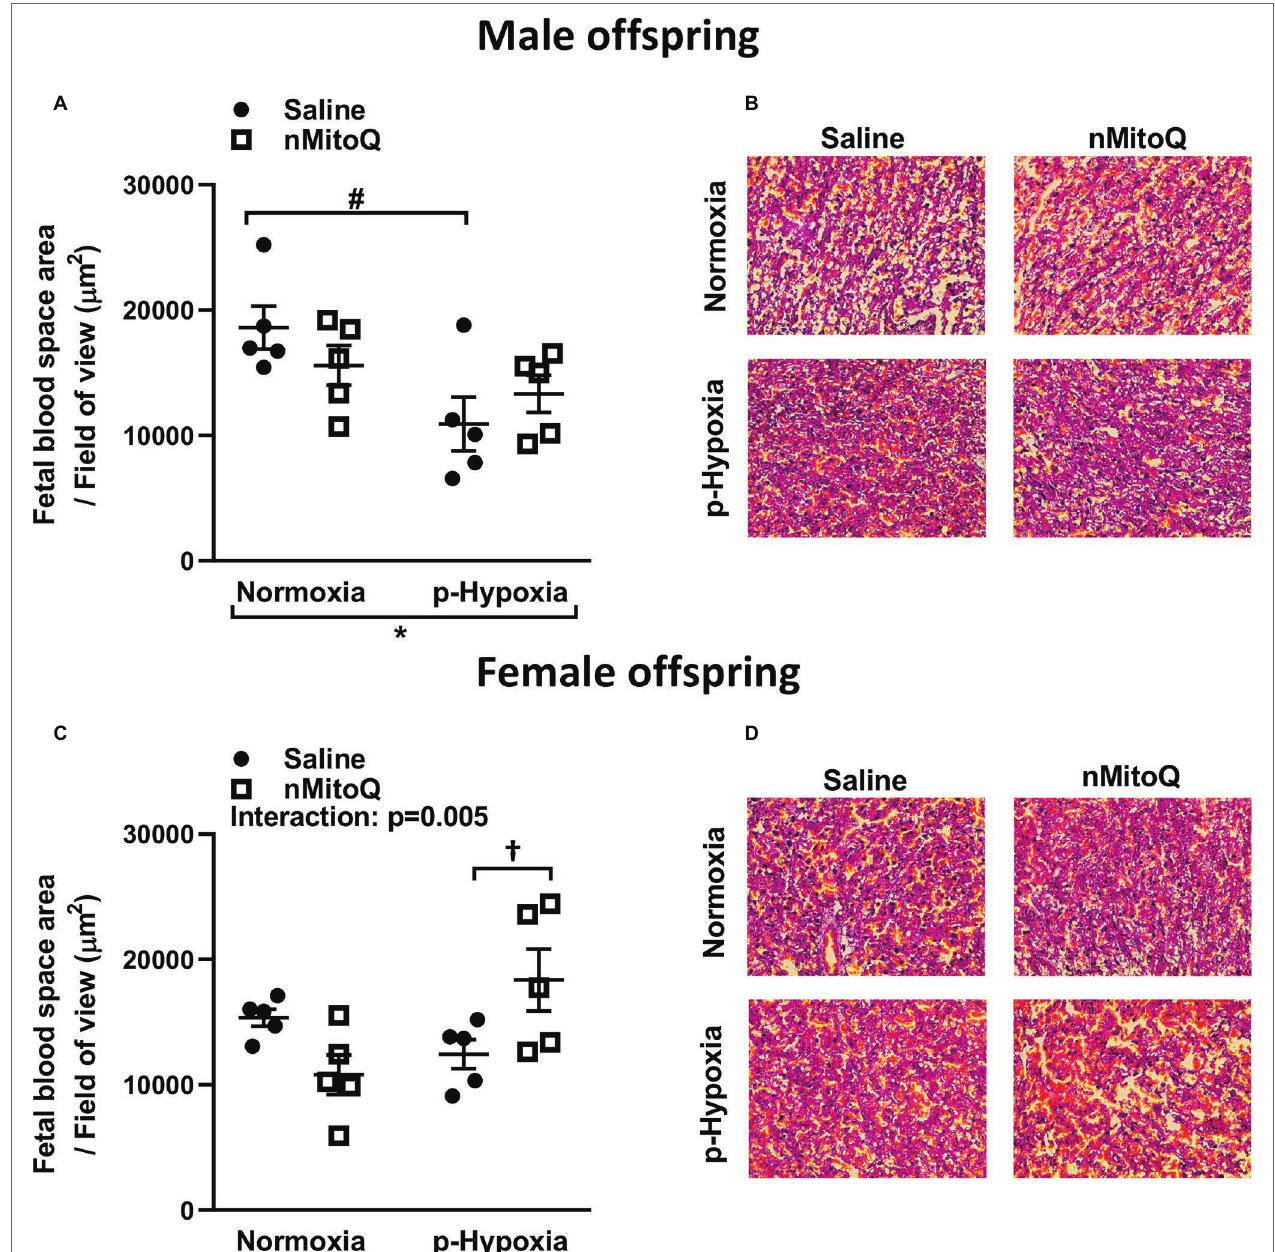
FIGURE 4 | Effects of nMitoQ treatment on fetal blood space area in prenatally hypoxic placentae of both male and female offspring. Fetal blood space area per field of view in labyrinth zones of placenta obtained from male (A) and female (C) fetuses on GD21. Representative images of H&E stained placental labyrinth sections in placentae of males (B) and females (D) . Data are represented as mean ± SEM. All groups were compared using a two-way ANOVA followed by Sidak’s post hoc test ( n = 5/group). * p < 0.05 group effect of prenatal hypoxia, # p < 0.05 compared to normoxia-saline, † p < 0.05 compared to hypoxia-saline